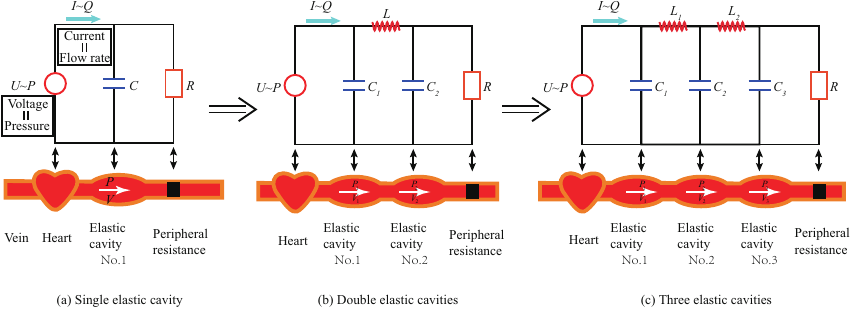
Figure 1. Classical finite-level elastic-cavity flow models of arteries and its analogous functional circuits: ( a ) single elastic cavity; ( b ) double elastic cavities; ( c ) three elastic